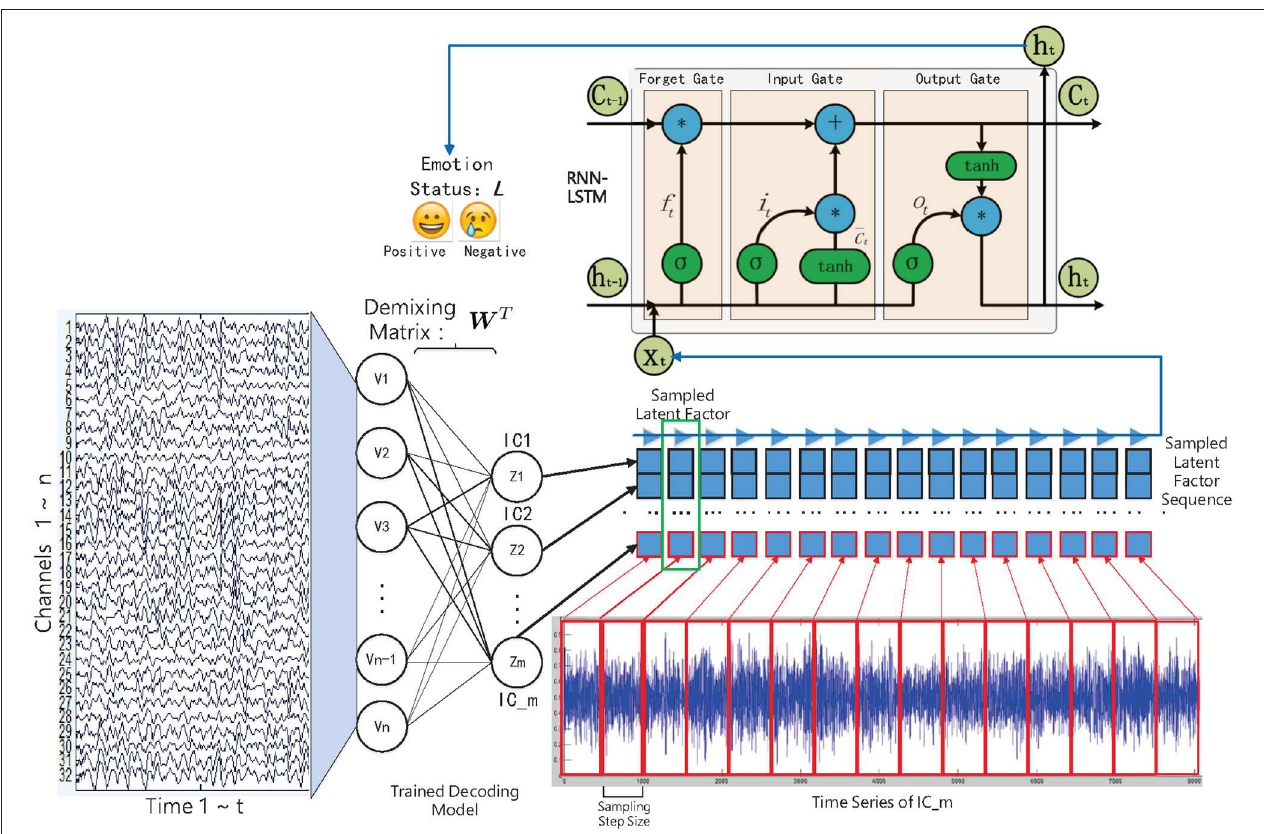
FIGURE 1 | The decoded EEG factors and recurrent neural network-based emotion recognition approach